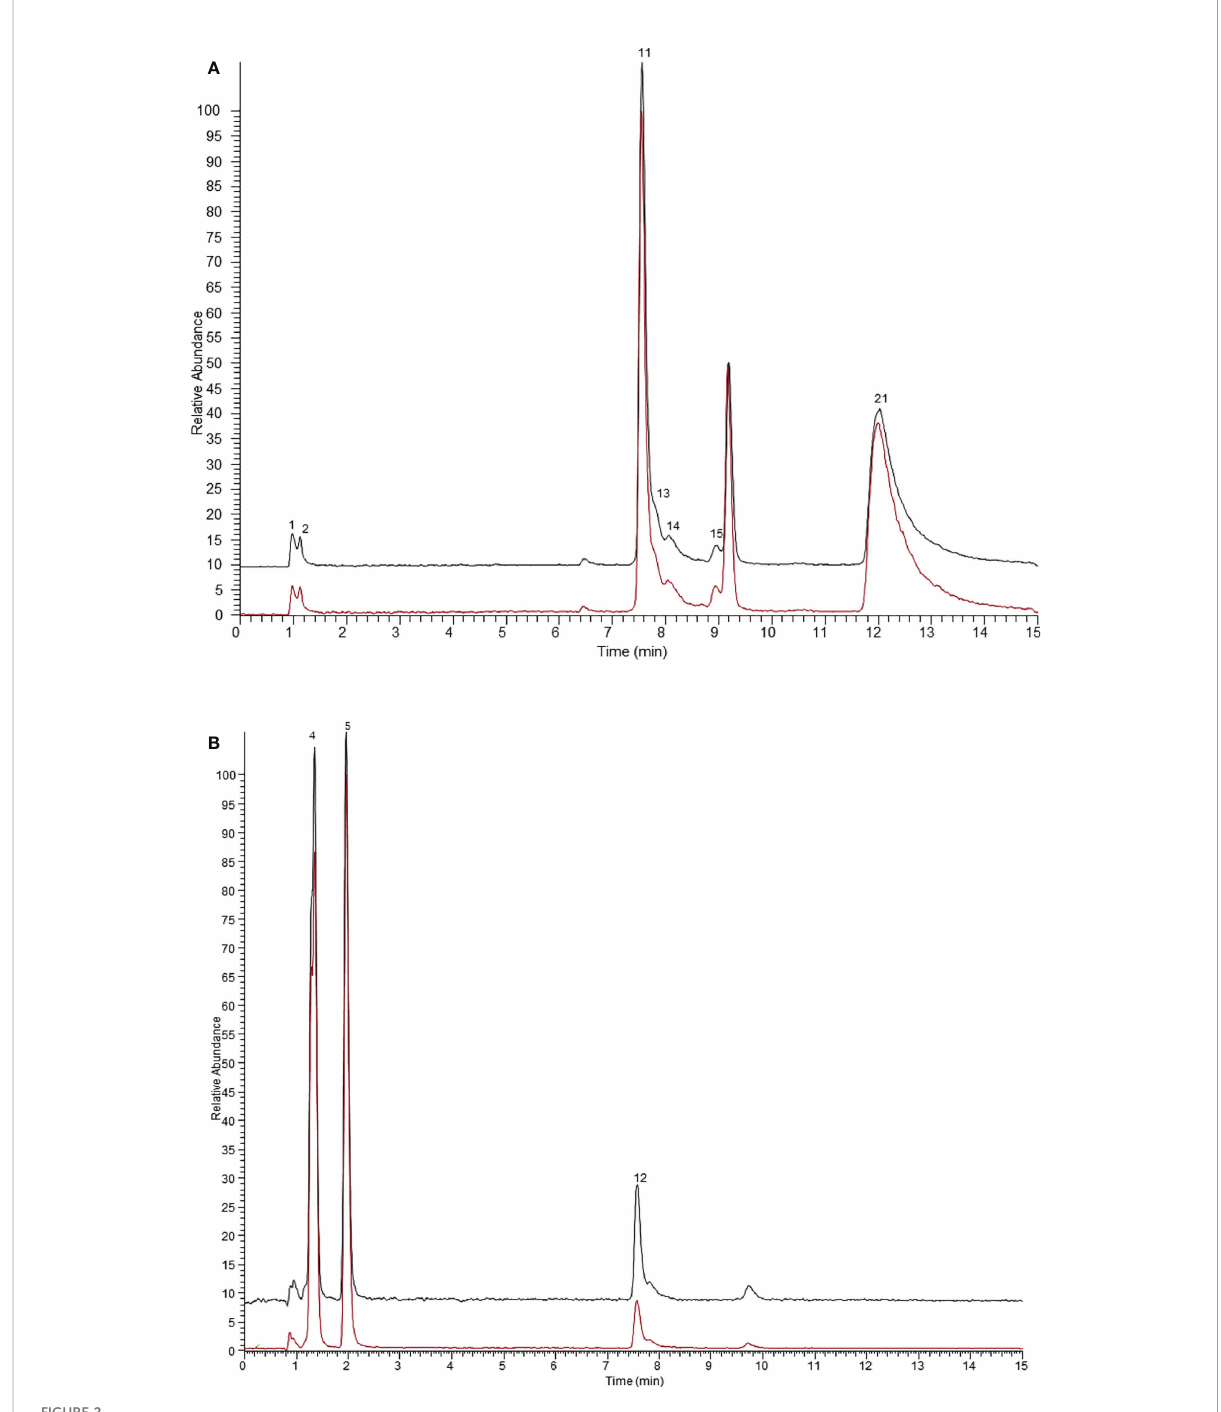
FIGURE 2 The ultra fi ltration UHPLC-Q-Exactive Orbitrap MS chromatograms of the potential ER b ligands in Arnebiae Radix . (A) Extracted ion chromatograms of compounds bound to ER b in negative ion mode. (B) Extracted ion chromatograms of compounds bound to ER b in positive ion mode. The black line represents active ER b group, the red line represents denatured ER b